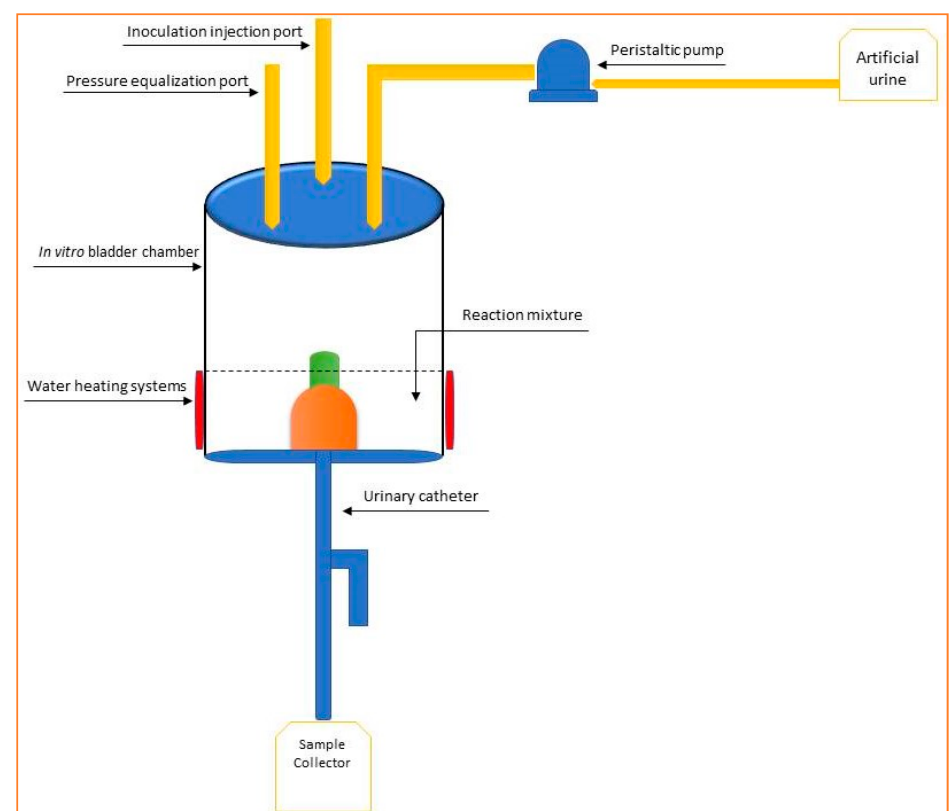
Figure 1. Schematic representation of the in vitro catheterization model.